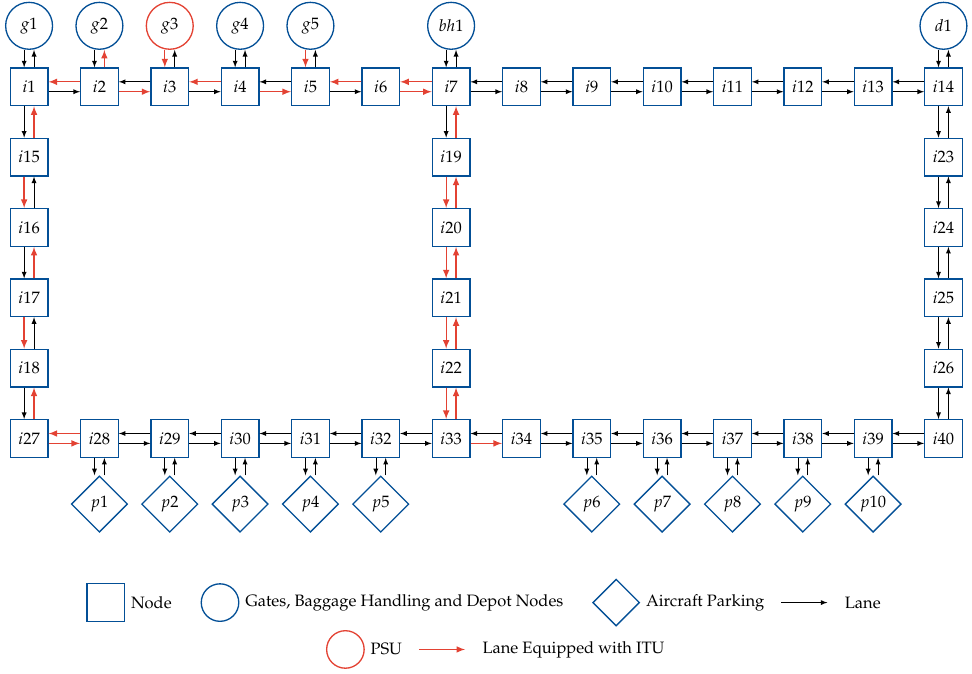
Figure 5. Graph of the Fictitious Airport instance (Note: Optimal charging infrastructure obtained with DICP-MV model.) Adapted with permission from Helber et al.